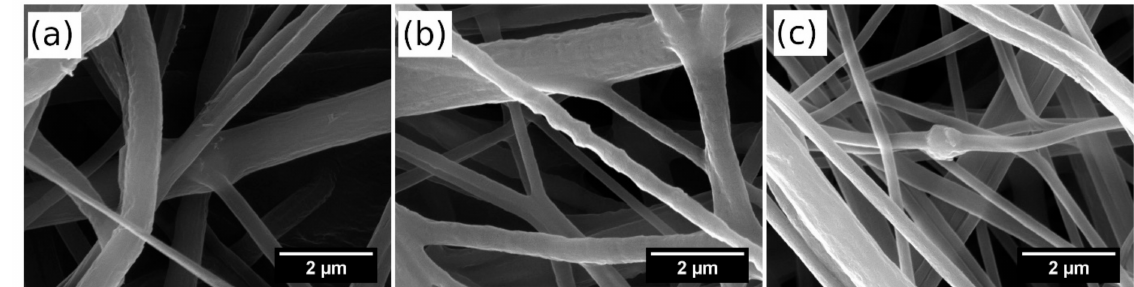
Figure 4. SEM images of PCL/Gel nanofibers doped with ( a ) 6 wt.%, ( b ) 9 wt.%, and ( c ) 12 wt.% HNT.